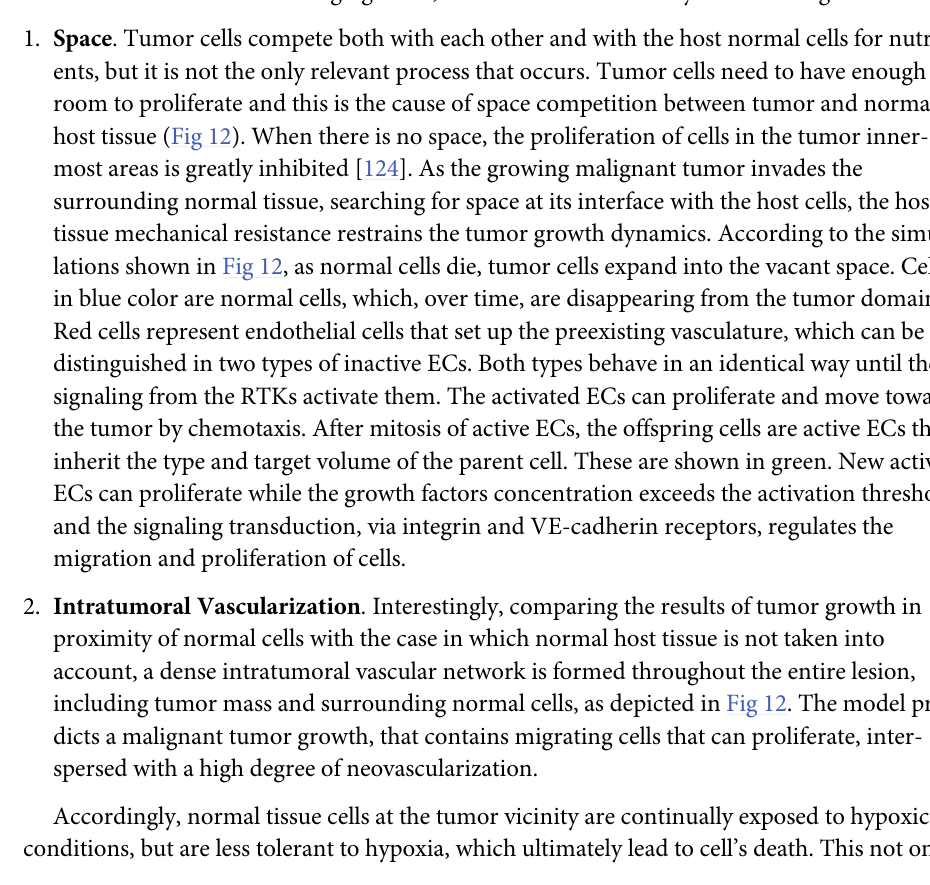
PLOS Computational Biology | https://doi.org/10.1371/journal.pcbi.1009081 June 23,